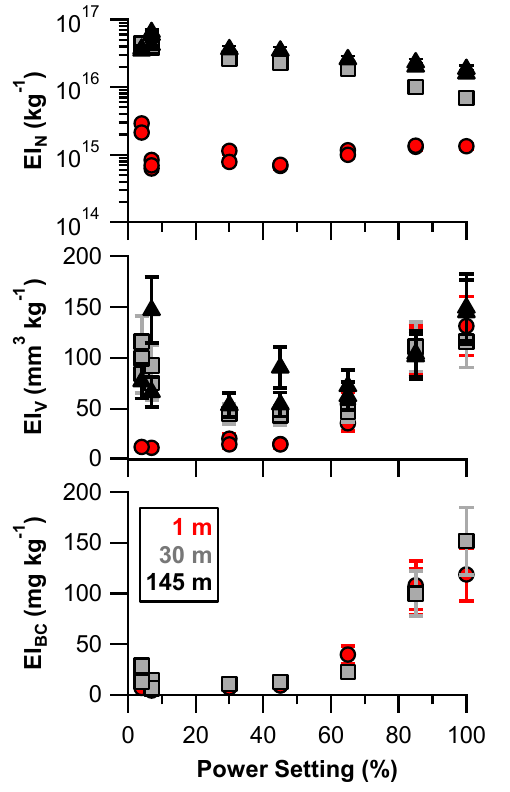
Fig. 7. Number and volume EIs at 1, 30, and 145 m behind the exhaust plane for one engine test (i.e., at constant ambient temper- ature). Black carbon mass was not measured at the 145 m probe. Data are solely from the #3 engine. Individual measurement uncer- tainties of 12% for EI N (often below the figure resolution) and 22% for EI V and EI BC are shown as error bars.